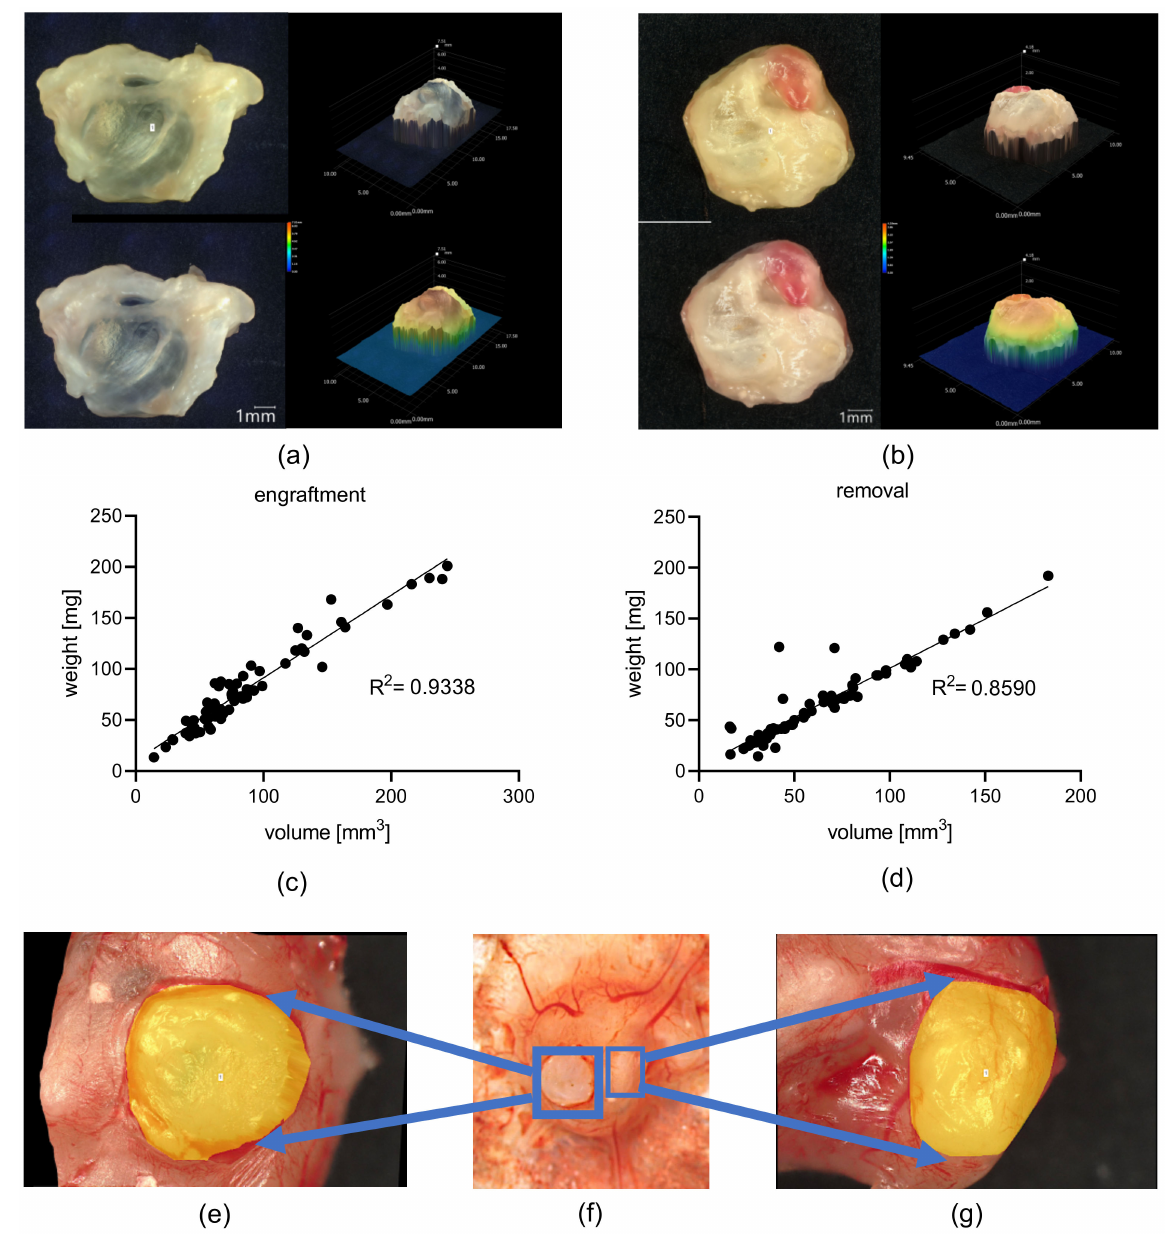
Figure 8. Three-dimensional volume measurements. Measurement of cystic tissue before engraftment ( a ) and after removal from the CAM ( b ) using a Keyence VHX-7000 microscope, including 2D and 3D images of the cystic tissue with volume measurements of the manually defined structure of interest. Linear regression analysis of weight (mg) obtained with a precision balance and volume (mm 3 ) obtained with 3D microscopy of the cystic tissues before engraftment and after removal ( c , d ). Each point represents a single measurement of weight and volume obtained from three nephrectomies ( n = 66). The calculated linear regression is depicted by the continuous line. Microscopic image of the bottom of a cystic tissue ( f ) with visible newly formed cysts magnified in ( g , e ) and marked with yellow